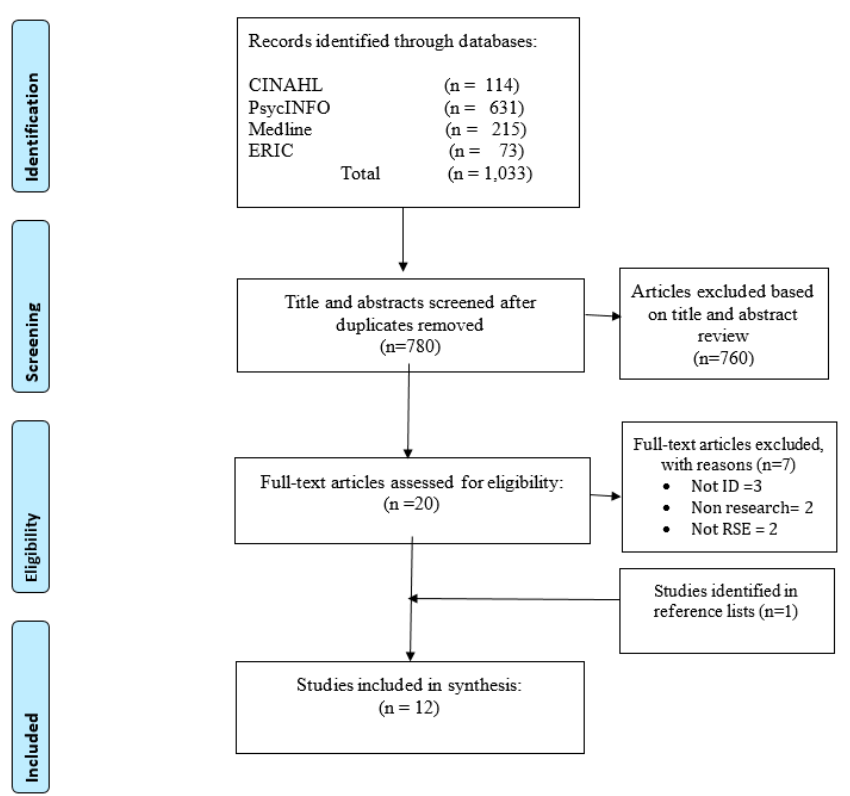
Figure 1. Preferred reporting items for systematic reviews and meta-analyses (PRISMA) flow diagram with search results.